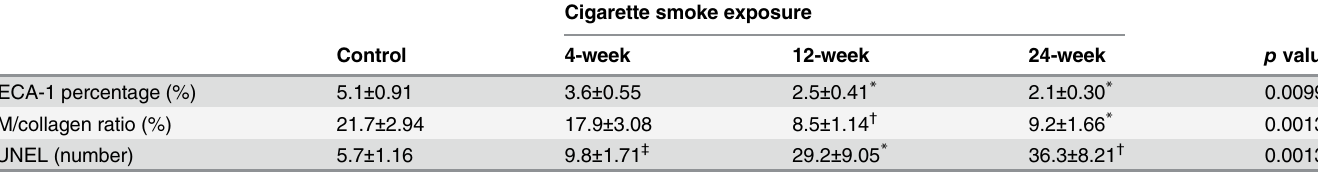
Table 3. RECA-1, Masson ’ s trichrome and TUNEL stain data in the experimental